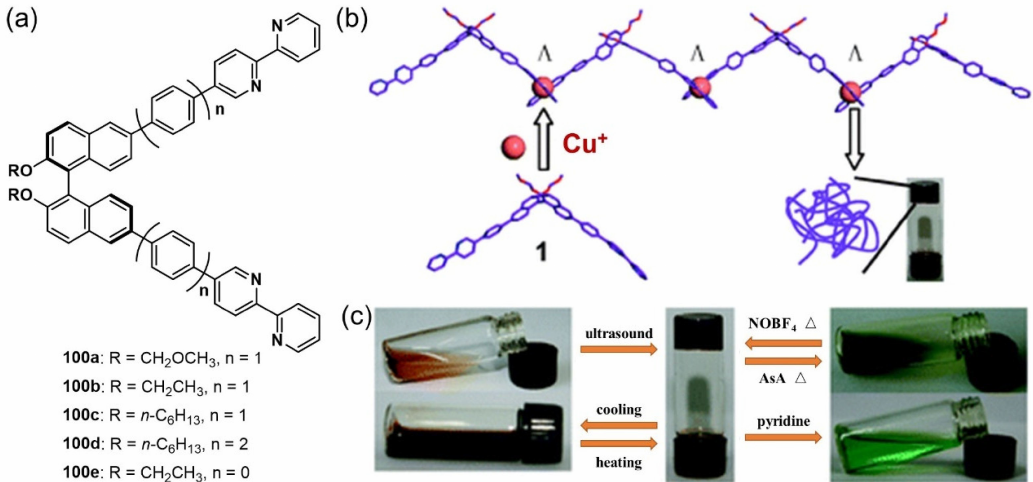
Figure 43. ( a ) The structures of ligands 100 . ( b ) A schematic representation of the possible self- assembly processes of the coordination polymer gel Cu(I)- 100 . ( c ) Phase transition behavior of the gel Cu(I)- 100 triggered by sonication, temperature, chemical redox reaction and solvent. Reprinted with permission from Ref. [122]. Copyright (2010), Royal Society of Chemistry.